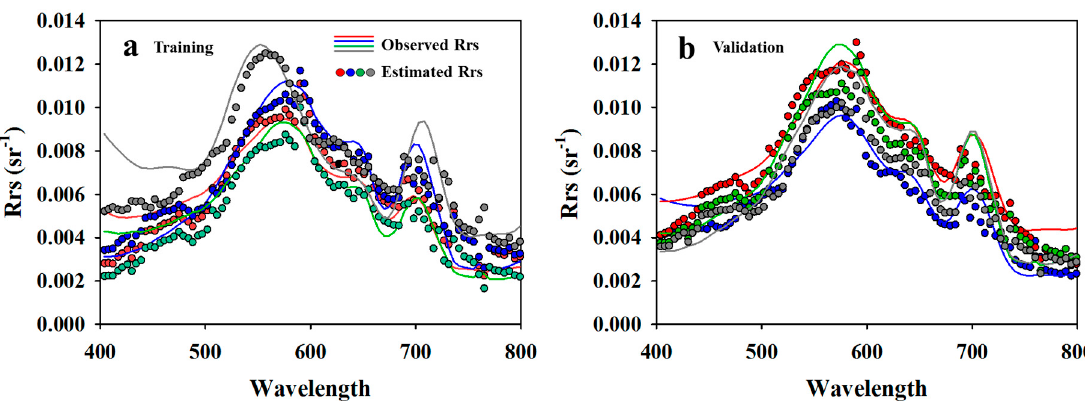
Figure 5. Example of comparison between observed reflectance spectra and estimated spectra: ( a ) training result of reflectance and ( b ) validation result. Straight lines indicate the observed reflectance and the marks represent the estimated reflectance from SAE-ANN. For training results, four estimated and observed spectra were selected with respect to 15th point on August 12, 2016, 7th point on September 20, 2016, 7th point on September 11, 2017, and 10th point on October 25th, 2017. For validation results, four estimated and observed spectra were selected with 13th point on September 20, 2016, 20th point on October 14, 2016, 7th point on September 15, 2017, and 1st point on October 25, 2017.